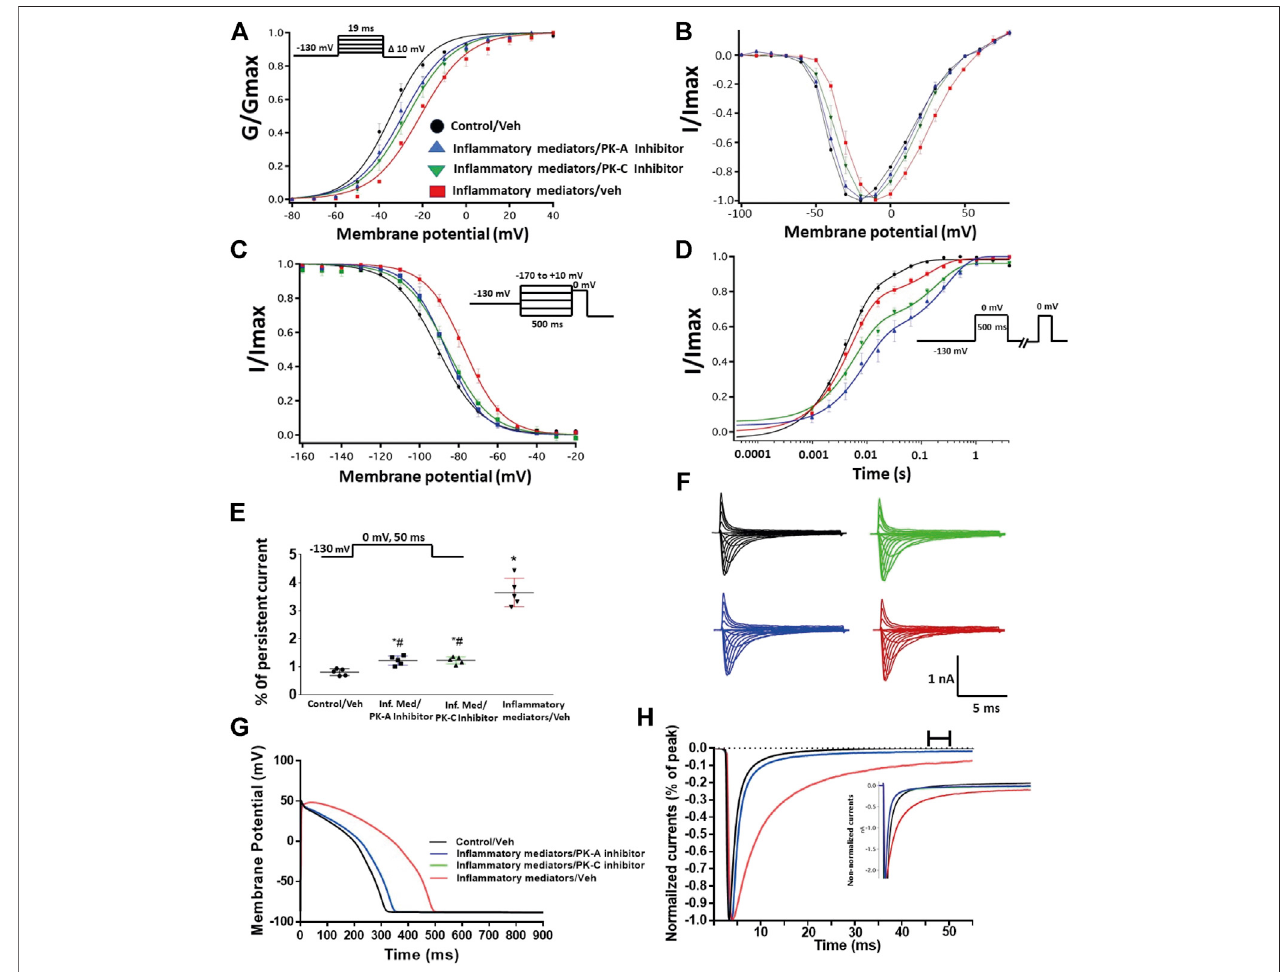
FIGURE 3 | (A) Effect of PK-A inhibitor (H-89, 2 µM for 20 min) or PK-C inhibitor (Gö 6,983, 1 µM for 20 min) or their vehicle on the conductance curve Nav1.5 transfectedCHOcellsincubated inthein fl ammatorymediatorsfor24 hwiththeinsertshowingtheprotocol( n (cid:2) 5,each). (B) IVcurves (C) Effect ofPK-Ainhibitor(H-89, 2 µM for20 min) or PK-Cinhibitor (Gö 6,983, 1 µM for20 min)or their vehicle on SSFIofNav1.5transfectedCHO cellsincubated inthe in fl ammatorymediators for 24 h withtheinsertshowingtheprotocol( n (cid:2) 5,each). (D) EffectofPK-Ainhibitor(H-89,2 µMfor20 min)orPK-Cinhibitor(Gö6,983,1 µMfor20 min)ortheirvehicleon recovery from fast inactivation of Nav1.5 transfected CHO cells incubated in the in fl ammatory mediators for 24 h with the insert showing the protocol ( n (cid:2) 5, each). (E) Effect of PK-A inhibitor (H-89, 2 µM for 20 min) or PK-C inhibitor (Gö 6,983, 1 µM for 20 min) or their vehicle on the percentage of persistent sodium currents of